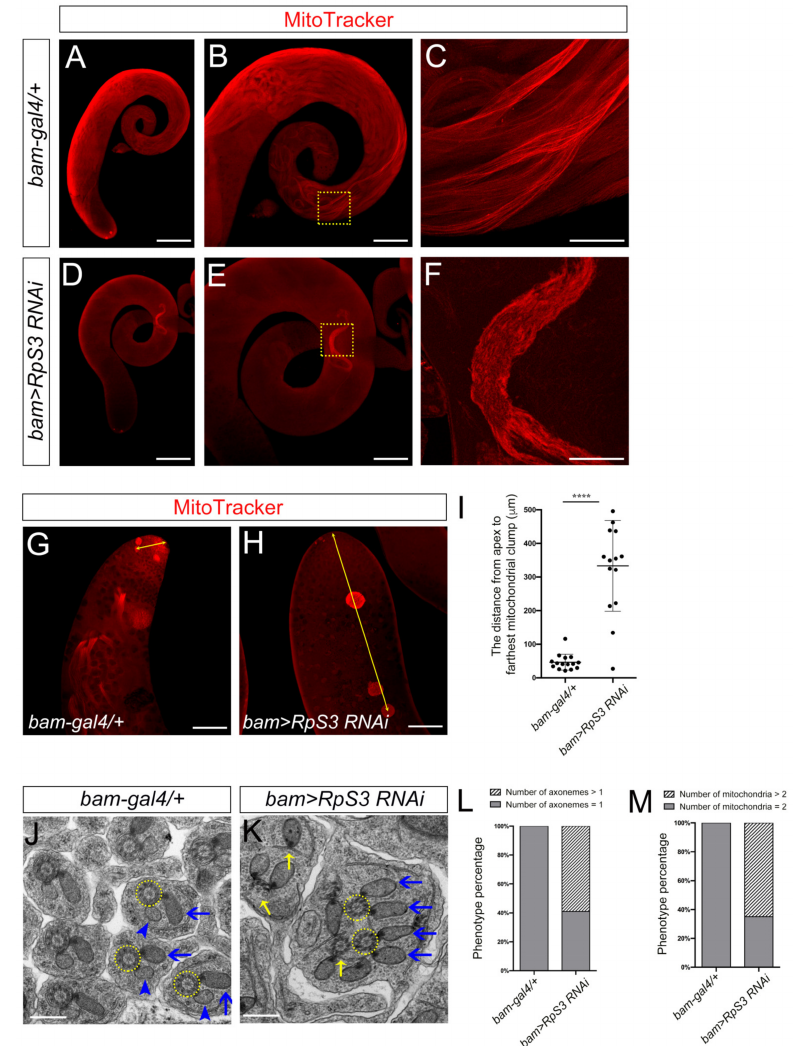
Figure 5. The RpS3 -knockdown testis displayed mitochondrial defects. ( A – H ) MitoTracker staining (red) indicated the functional mitochondria in the testes with indicated genotypes. Compared with that in control testes ( A – C ), the functional mitochondria were severely decreased in RpS3- RNAi testes ( D – F ). The enlarged view of the dashed boxes in ( B , E ) are shown in ( C , F ), respectively. ( G , H ) show the mitochondrial clumps in the apical region of the testes. ( I ) The average distance from the apex to the farthest mitochondrial clump was quantified in the control ( n = 15) or RpS3 - knockdown testes ( n = 15). Each dot indicates one sample measured. **** p < 0.0001. ( J , K ) EM analysis of mitochondrial derivatives in elongating spermatids. In the representative image of control sample ( J ), an axoneme (outlined by a yellow dashed circle) interacts with one major mitochondrial derivative (with paracrystalline, indicated by a blue arrow) and one minor mitochondrial derivative (without paracrystalline, indicated by a blue arrowhead). In the RpS3 -knockdown cysts ( K ), one axoneme (yellow dashed circles) is linked with two major mitochondrial derivatives with accumulated paracrystalline (blue arrows), and some axonemes also show various degrees of defects (indicated by yellow arrows). ( L , M ) The number of mitochondrial derivatives or axonemes per spermatid was quantified in the control group ( n = 154) and in the RpS3 -knockdown group ( n = 150). The Chi-square test showed a significant relationship between the abnormality of axonemes/mitochondria and RpS3 knockdown. For ( L ), X 2 (1, N = 304) = 127.2, p < 0.0001. For ( M ), X 2 (1, N = 304) = 148.5, p < 0.0001. Scale bars: 200 µ m ( A , D ); 100 µ m ( B , E , G , H ); 25 µ m ( C , F ); 500 nm ( J,K